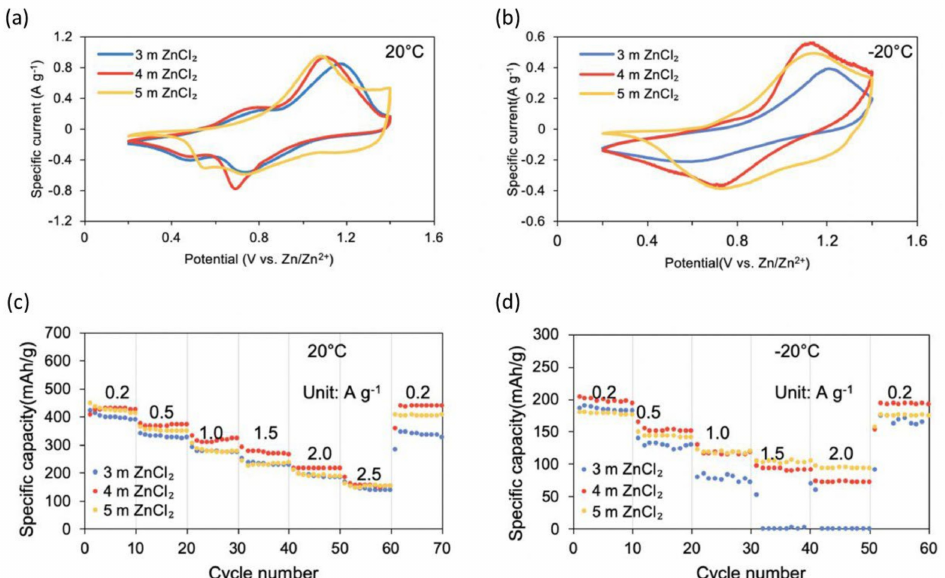
Figure 20. Under 0.5 mV s − 1 , the CV curves of the batteries based on the hydrogel electrolytes prepared using 3/4/5 m ZnCl 2 combined with 1.2 g of xanthan gum at ( a ) 20 ◦ C and ( b ) − 20 ◦ C. Rate performances of the batteries based on the electrolytes prepared using 1.2 g of xanthan gum combined with 3/4/5 m ZnCl 2 solution at ( c ) 20 ◦ C and ( d ) − 20 ◦ C. Reprinted with permission from Ref. [107]. Copyright 2021